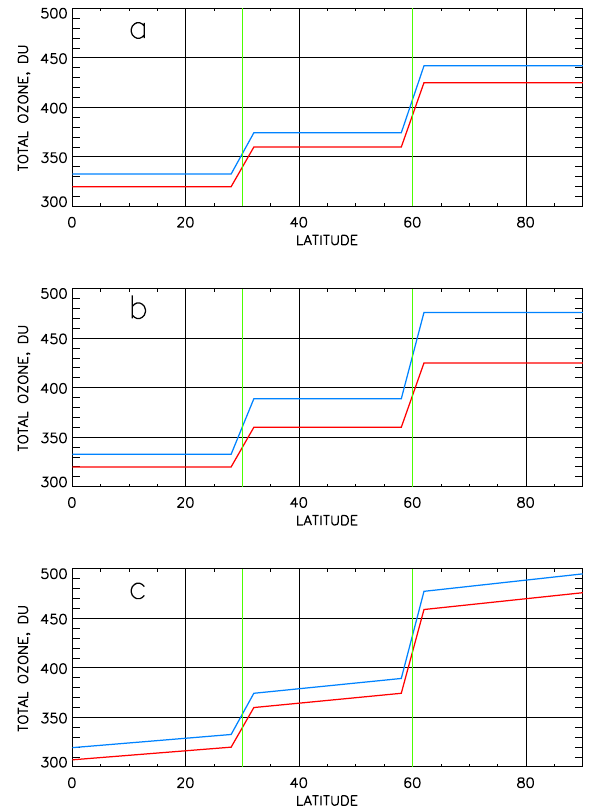
Fig. 2. Schematic of the total ozone values at the sub-tropical and Polar fronts for two instruments for three specific cases of a bias. (a) constant bias between the two data sets, (b) a bias that is a function of latitude (or total ozone amount), (c) constant bias but the total ozone value increases with